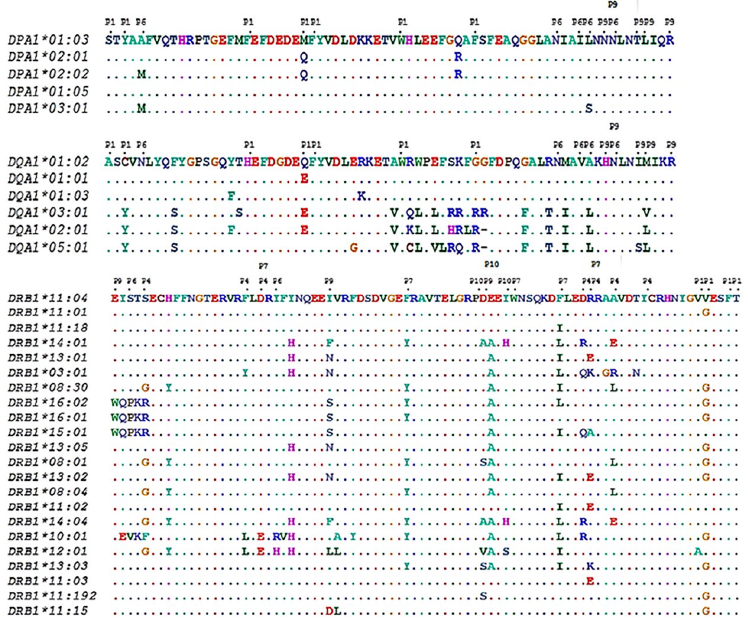
Fig 2. The amino acid sequence of exon 2 (partial) of the alleles that were identified in HLA-DPA1, -DQA1 and DRB1 in our WNV cases. The residues that form pockets P1, P4, P6, P7, P9 and P10 have been noted accordingly. Positions that have the same amino acid with the first sequence in other alleles are shown with